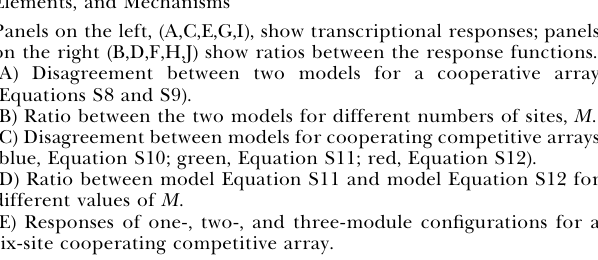
tration is constant in all cases. Found at doi:10.1371/journal.pcbi.0030084.sg001 (543 KB TIF). Figure S2. Dependence of Response on the Shape of Identical Gradients (A–D) Similar antagonistic gradients may have different shapes, which correspond to different form of the function ( f ( x ) in Equation 7. However, the presence of the response function maximum ( y ( x ) in Equation 7 is independent from the form of the function f ( x ). All simulations were performed with the same concentration values and the same binding constant